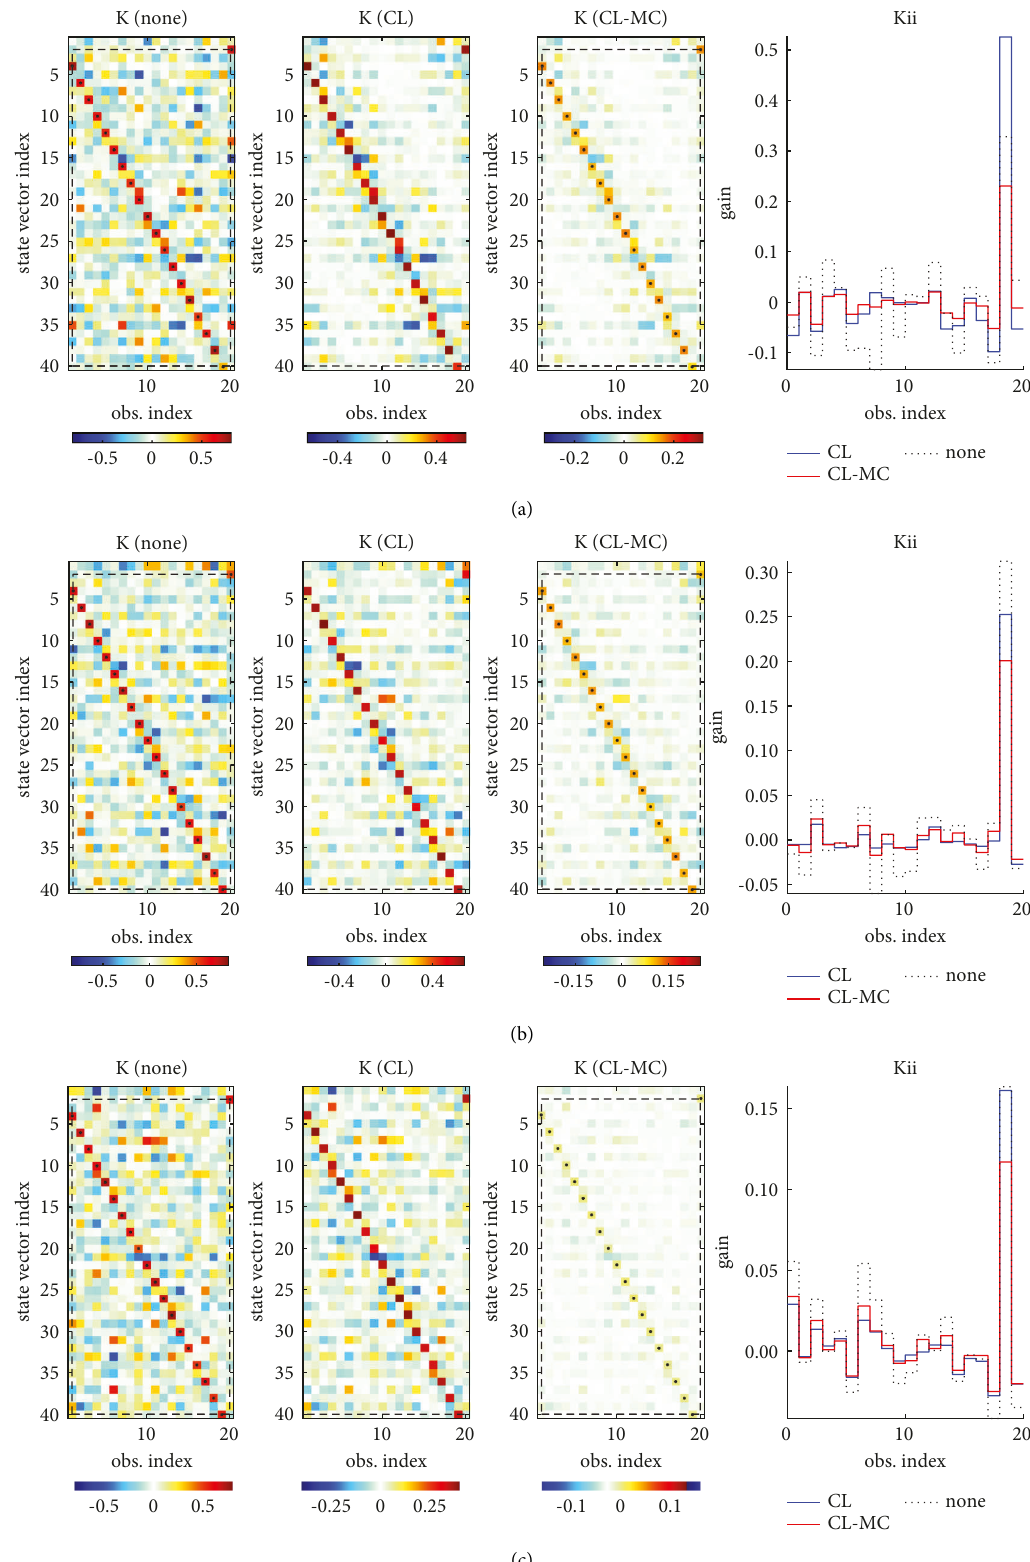
Figure 3: Influence of the CL and CL-MC on the Kalman gain matrix for model component i � 40. (a) Localization radius � 10. (b) Localization radius � 15. (c) Localization radius � 20. “K(none)” represents the without using localization scheme; “K(CL)” and “K(CL- MC)” represent using and without using modified Cholesky decomposition, respectively. “Kii” denotes the Kalman gain from each observation for CL, CL-MC, and without using the localization